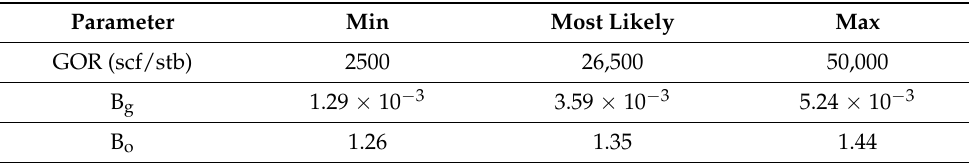
Figure 9. Distributions of formation volume factors for ( a ) gas ( B g ) and ( b ) oil ( B o ). Table 4. Triangular distribution